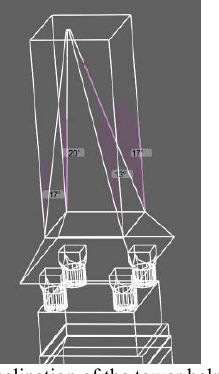
Figure 3. Declination of the tower helm in 2005